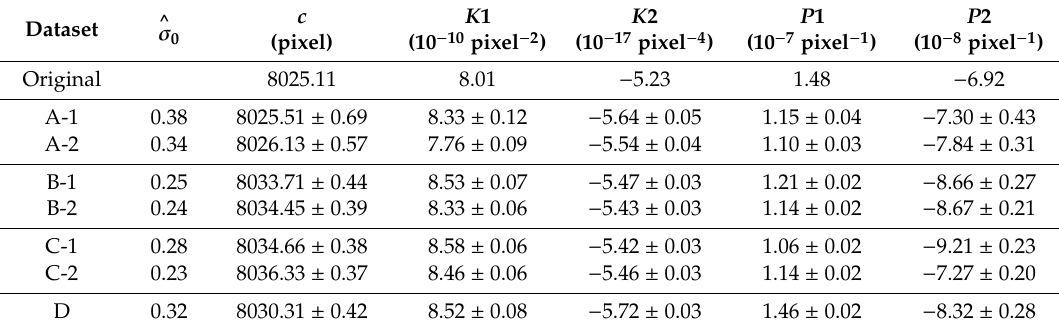
Table 5. Original and refined IOPs from the proposed IOP refinement strategy for the seven datasets.